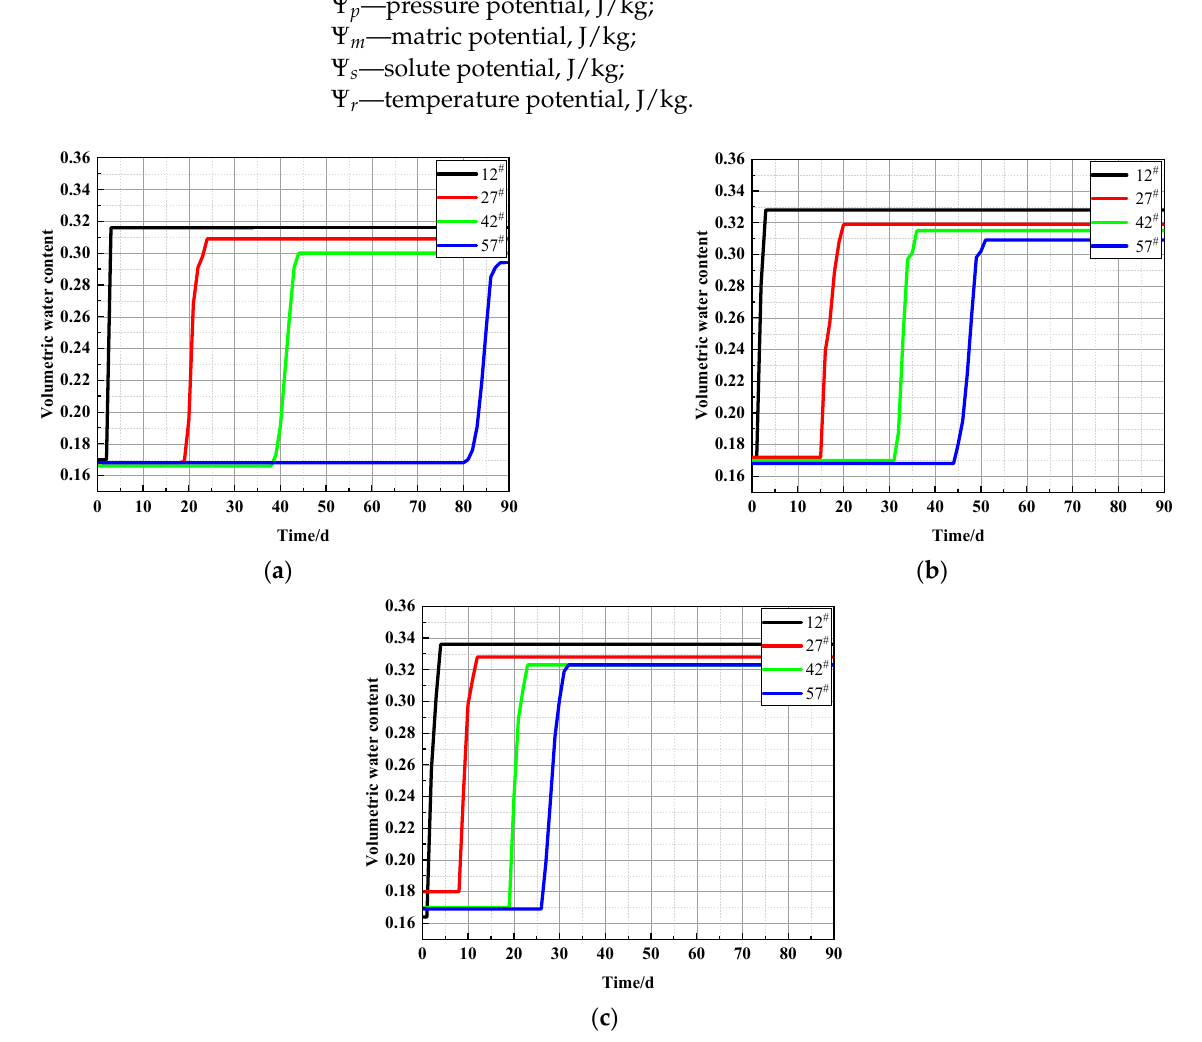
Figure 6. Variation of soil column volume water content with time for different NaCl contents: ( a ) 0%, ( b ) 0.3%, ( c ) 1.0% NaCl.